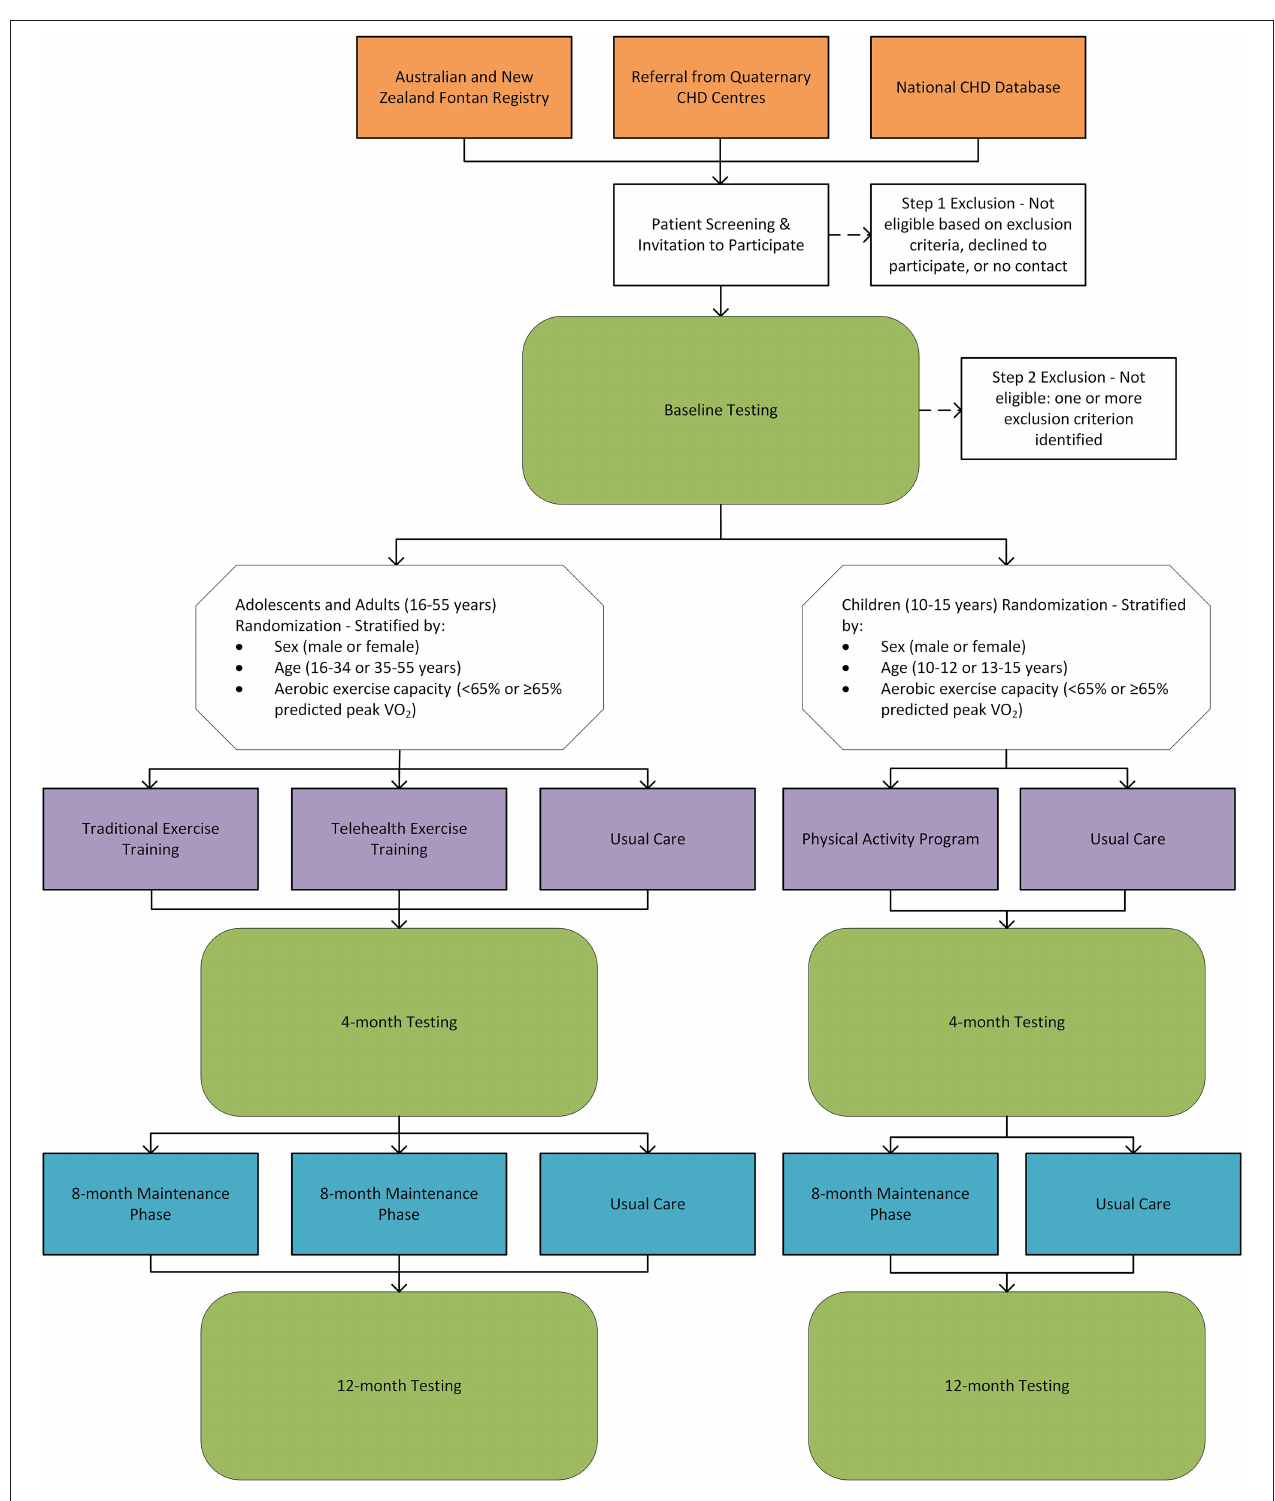
FIGURE 7 | The Fontan Fitness Intervention Trial (F-FIT) study design flow diagram.